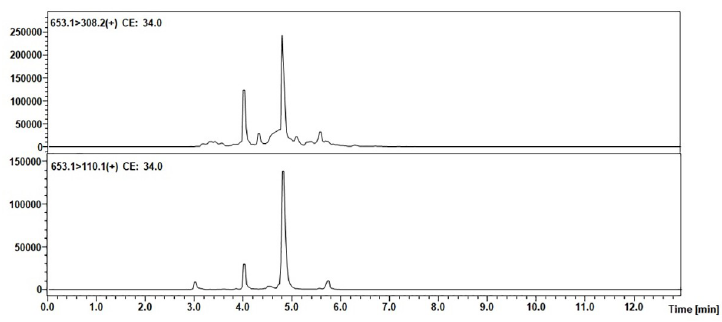
Fig 4. MRM chromatograms representing transitions corresponding to the model peptide with the H-LQTLEIPFHEIVTK(TPP)-OH sequence identified in the tryptic digest of an equine urine sediment sample from animal with diagnosed